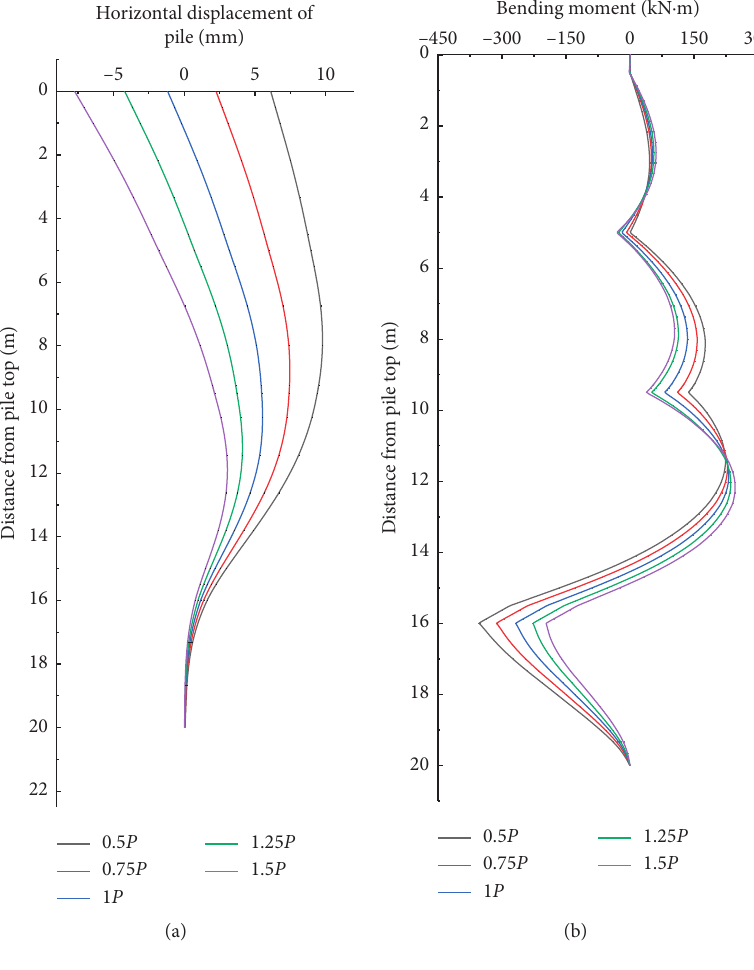
Figure 10: Pile internal force diagram. (a) Shear diagram. (b) Bending moment diagram.